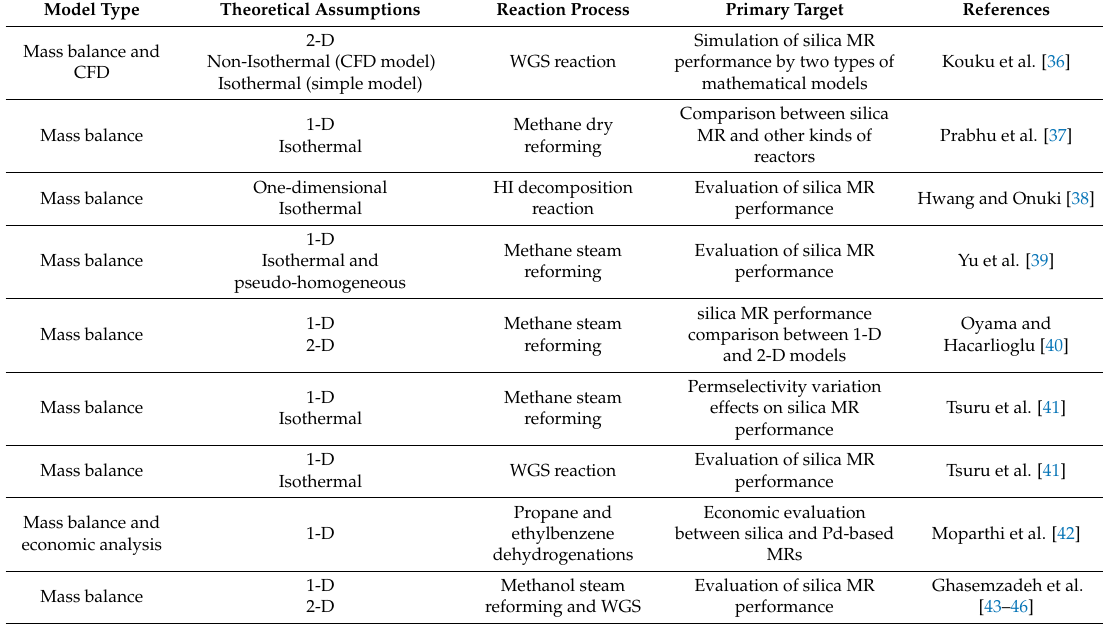
Table 4. A summary of evaluation for silica MR performance from modeling